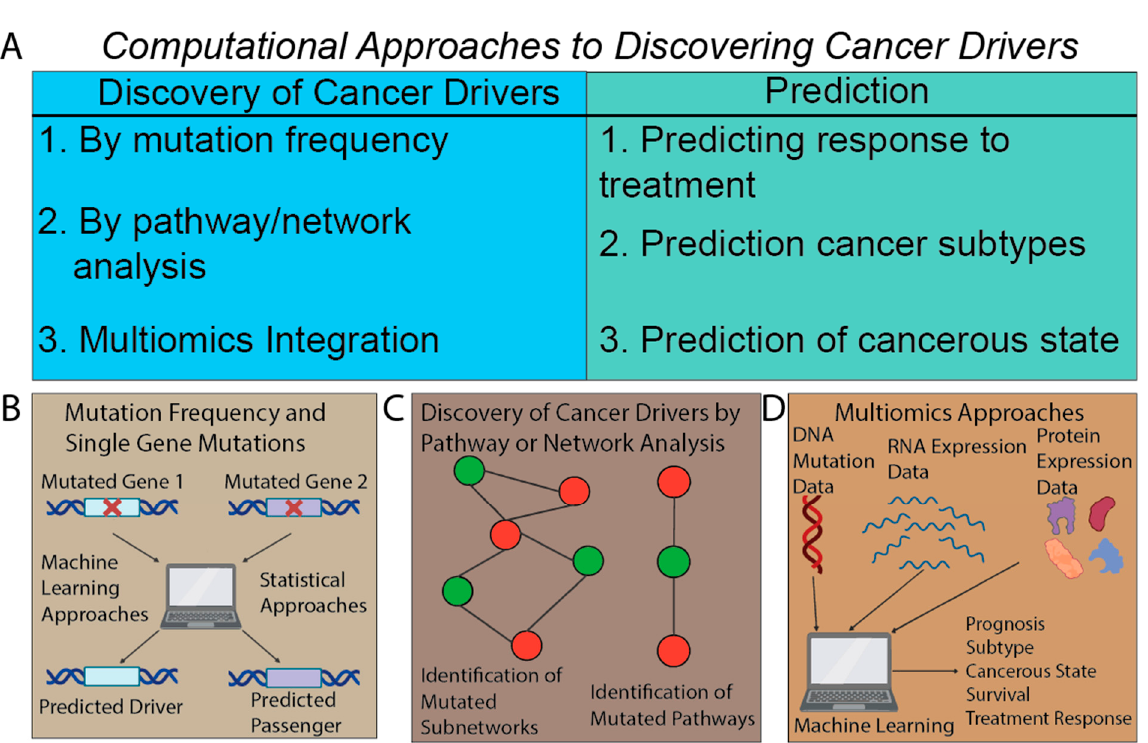
Figure 3. Overview of computational approaches for using mutational patterns beyond mutation signatures. ( A ) Computational approaches are used for discovery of cancer-driver mutations and for the prediction of cancer phenotypes using mutational patterns. ( B ) Single gene for distinction of cancer-driver mutations. ( C ) Network- and pathway-based methods to predict driver mutations and use mutational data for cancer-phenotype prediction. ( D ) Multi-omics approaches integrate mutations with different data types to improve discovery of cancer drivers and prediction of cancer phenotypes.